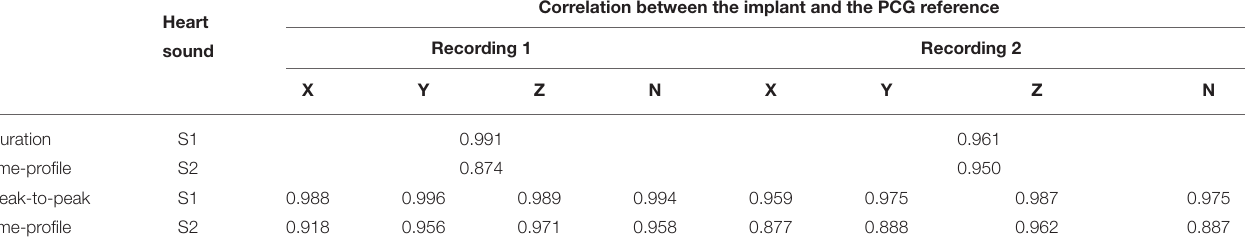
TABLE 2 | Validation of ACC recordings with a gold standard